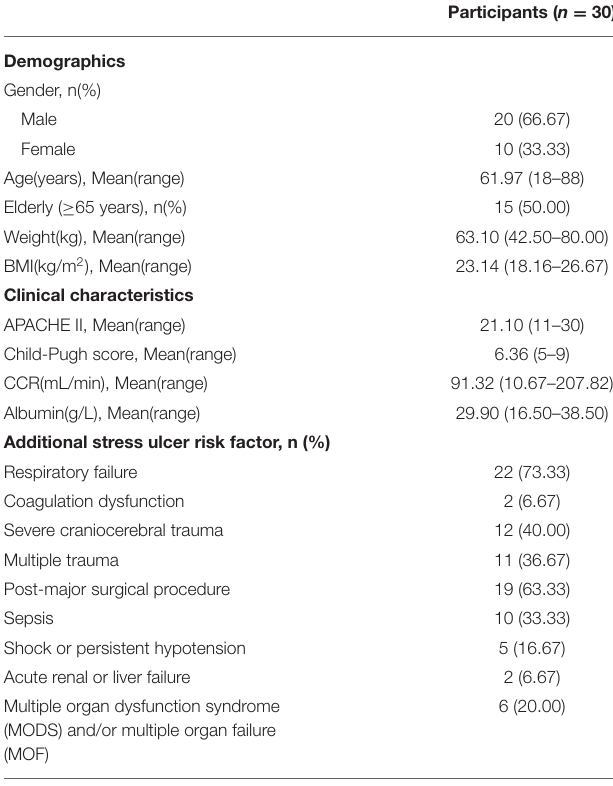
TABLE 1 | Baseline characteristics of all participants.